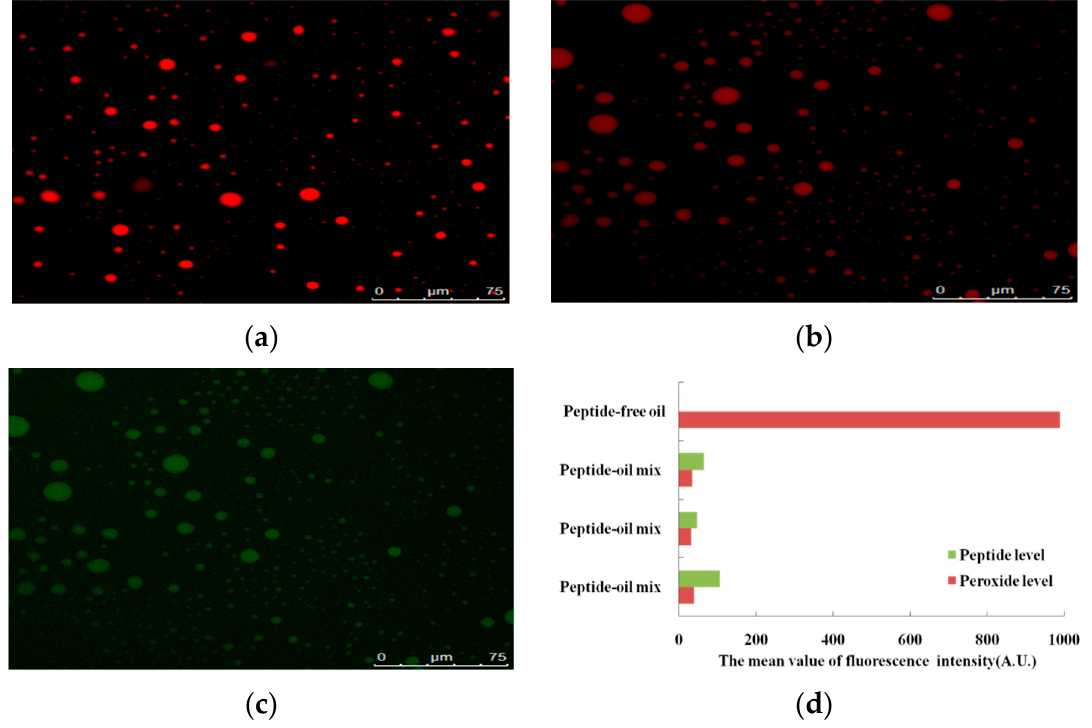
Figure 1. Effect of the peptide QITEGEDGGG against peroxides in oxidation oil. ( a ) The distribution of peroxide in walnut oil without any antioxidant. ( b ) The distribution of peroxide in peptide–oil. ( c )The distribution of peptide in peptide–oil. ( d ) A comparison of the peroxide level in peptide-free oil and peptide-oil mix, as well as the peroxide level and peptide level in peptide-oil mix. Peroxide level and peptide level are expressed as the mean value of intensity of fluorescence signals (A.U.). Red fluorescence presents the signal intensity of C11-BODIPY, the dye associated with peroxides, while the green fluorescence is the signal intensity of FITC, the dye associated with the peptide. Scale bar is 75 μ m.